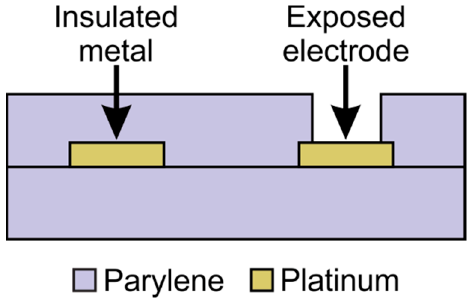
Figure 2. Cross section of a typical device showing insulated and exposed metal features, such as traces and electrodes, respectively.